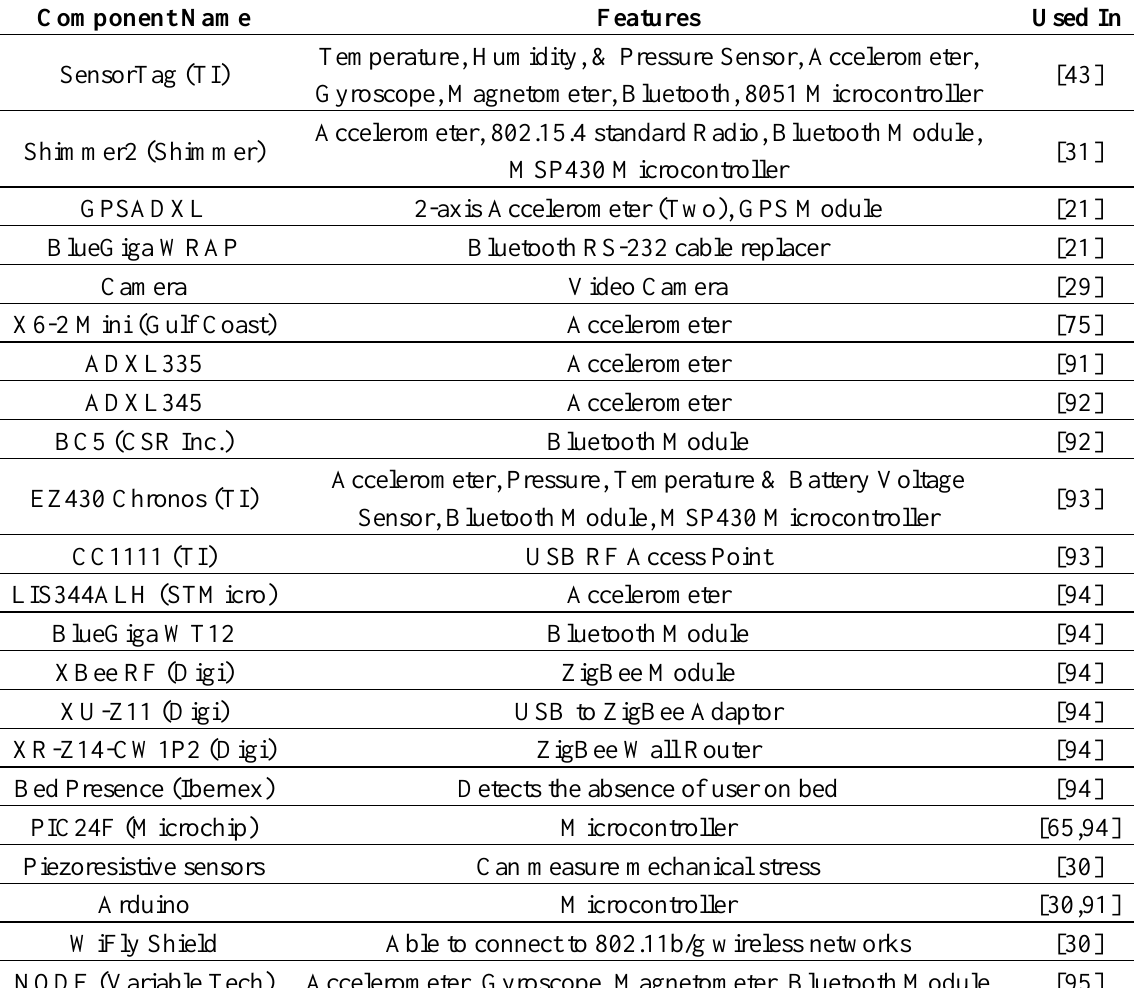
Table 3. External components, used in SP-based fall detection and prevention